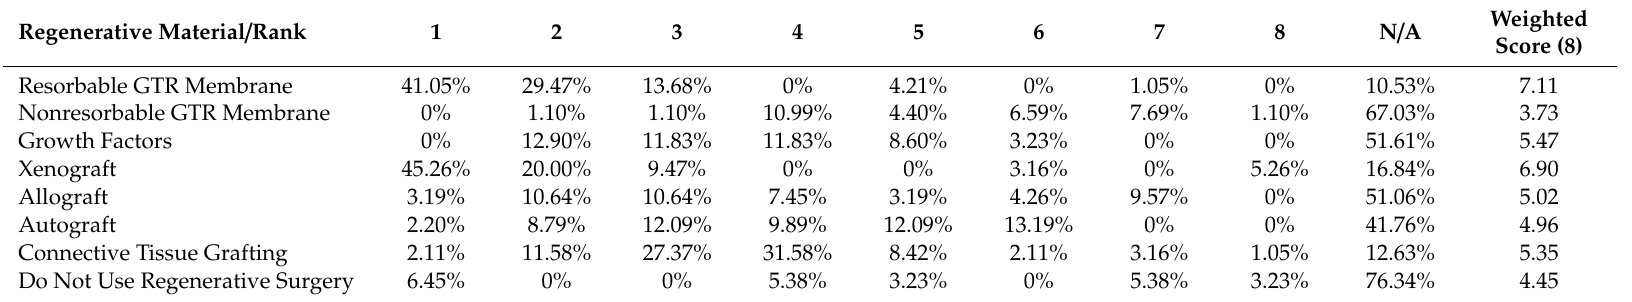
Table 7. Regenerative materials ranking: weighted score out of 8 (higher = more commonly